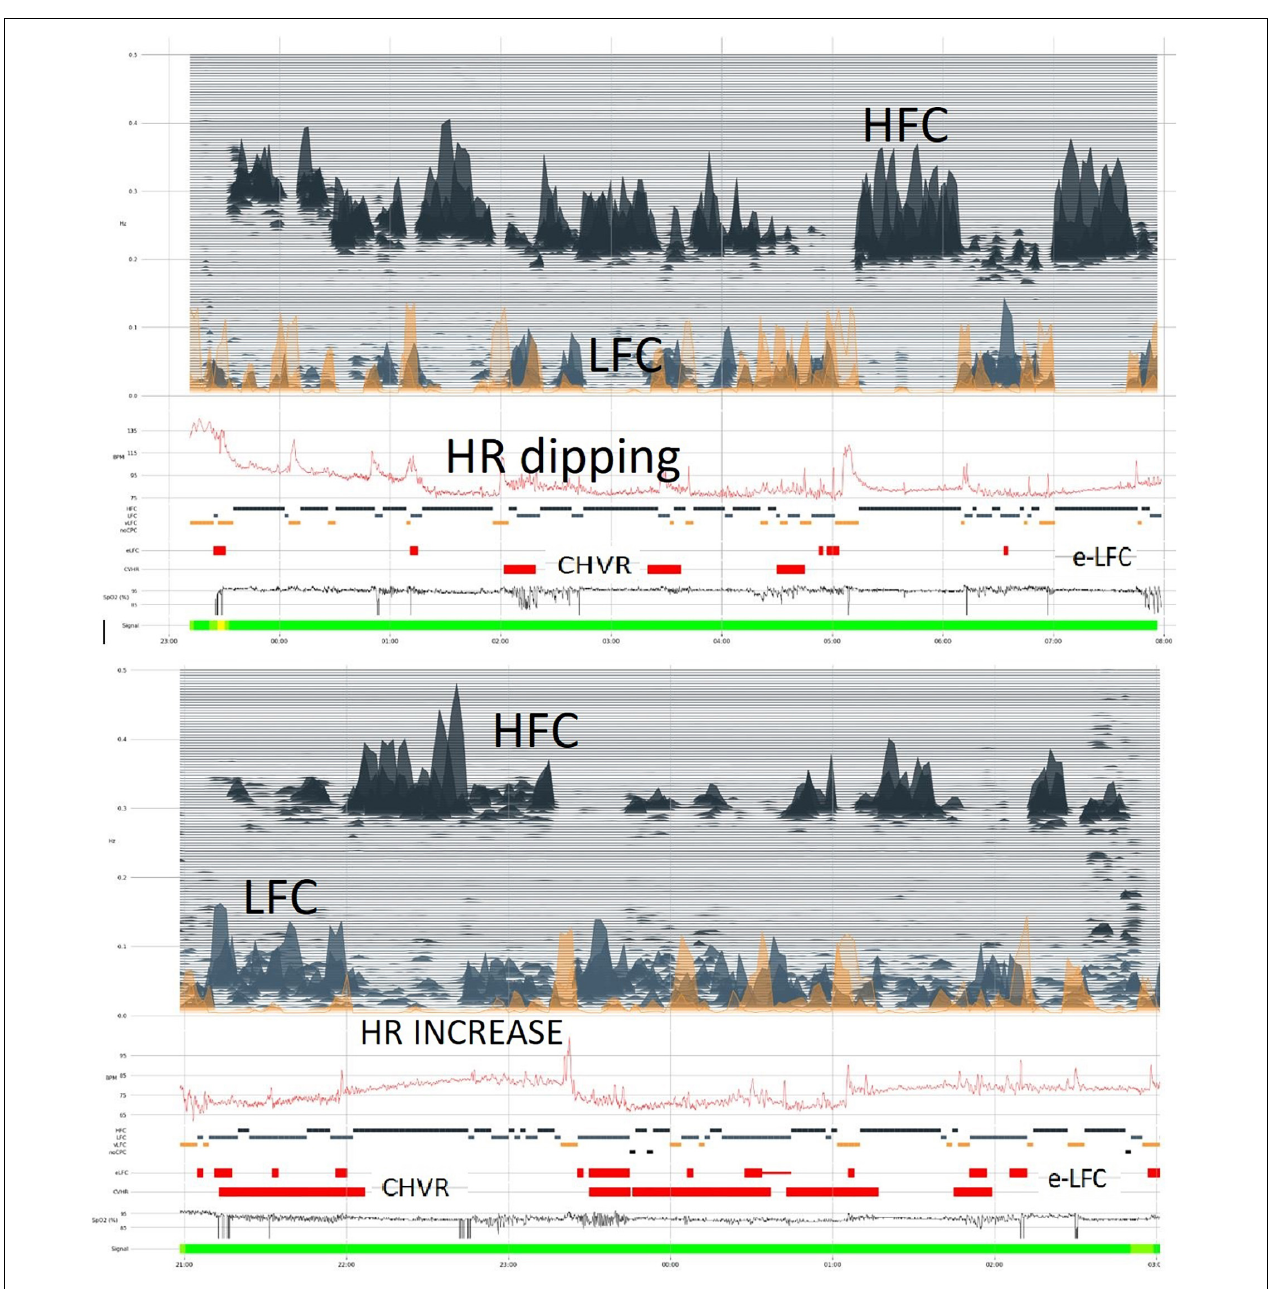
FIGURE 2 | Photoplethysmogram/oximetry-based CPC-heart rate analysis. The oximetry-based analysis provides a full CPC-sleep spectrogram, an apnea-hypopnea index by integrating CPC LFC and oxygen desaturation events, and a profile of heart rate across the night. In the upper segment of the figure, “dipping” of heart rate is noted along with abundant high frequency coupling/stable sleep. In the lower sample, there is less stable state, but the heart rate profile is distinctly abnormal, with an elevation even during stable state. Such relative tachycardia during stable NREM sleep may suggest obstructive hypoventilation. In both examples, oxygen desaturation itself is mild. Stable and unstable sleep (HFC and LFC, respectively) occur intermittently through the night. HFC, high frequency coupling; LFC, low frequency coupling; e-LFC, elevated low frequency coupling; HR, heart rate; CHVR, cyclic heart rate variation.